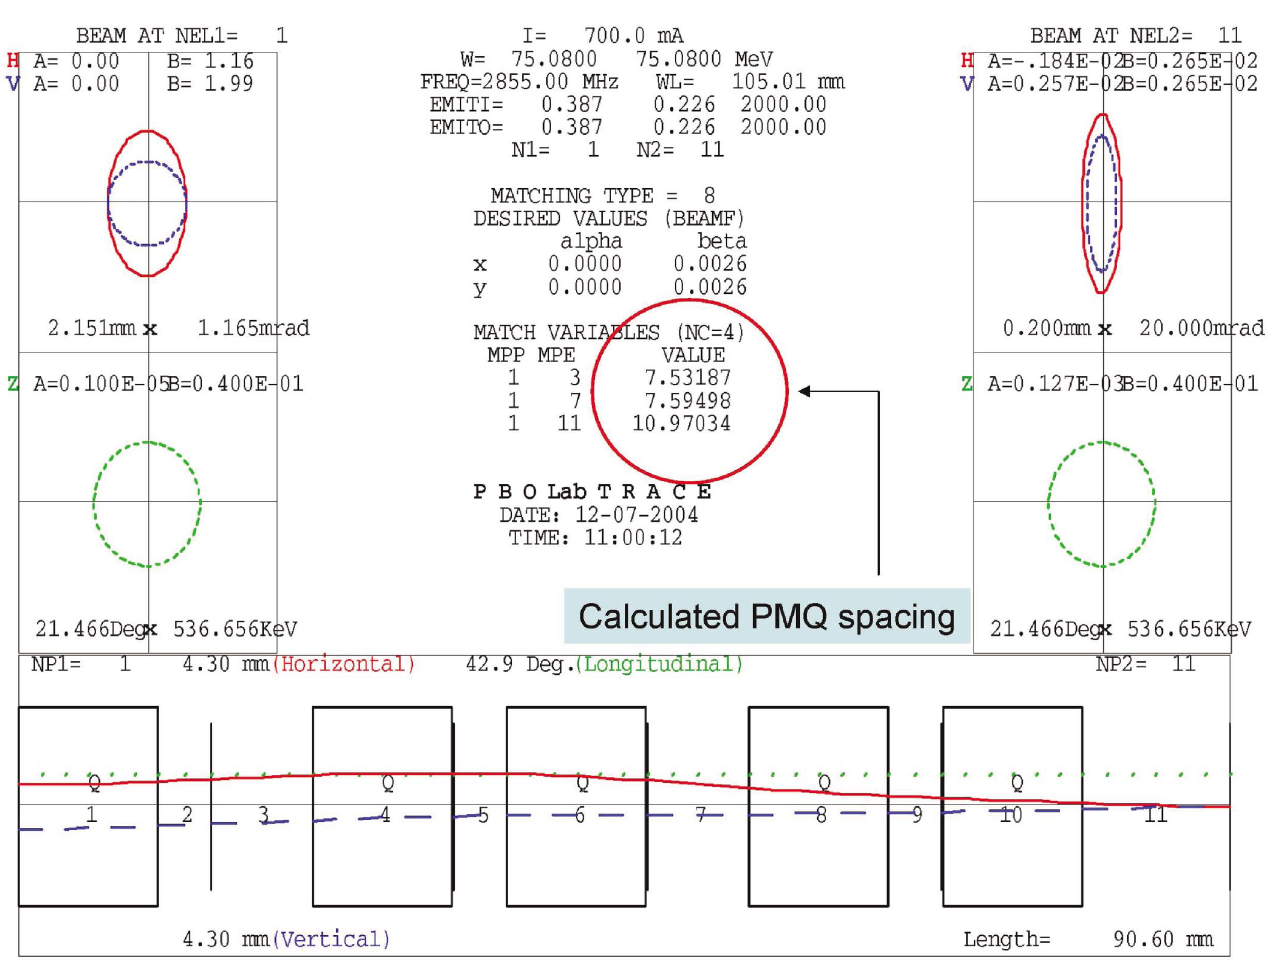
FIG. 20. (Color) Typical TRACE3D output (screen shot) specifying the spacing between PMQs and their position with respect to the beam